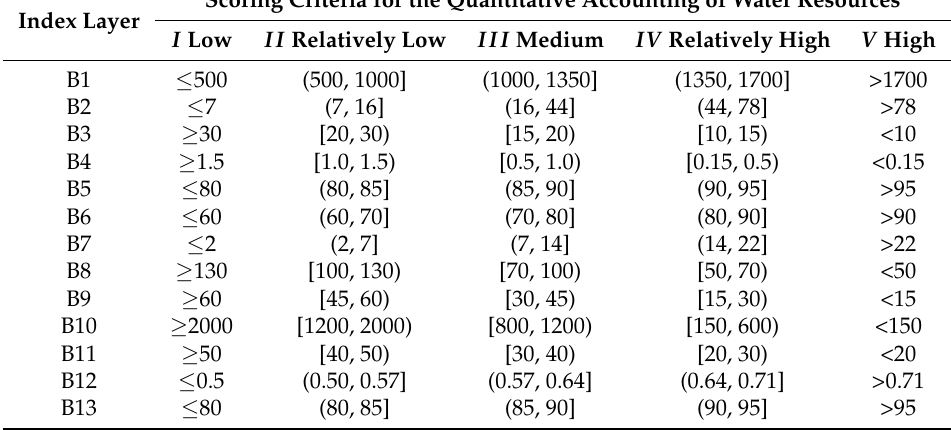
Table 3. Indicator system and scope of the sustainable development of water conservation.